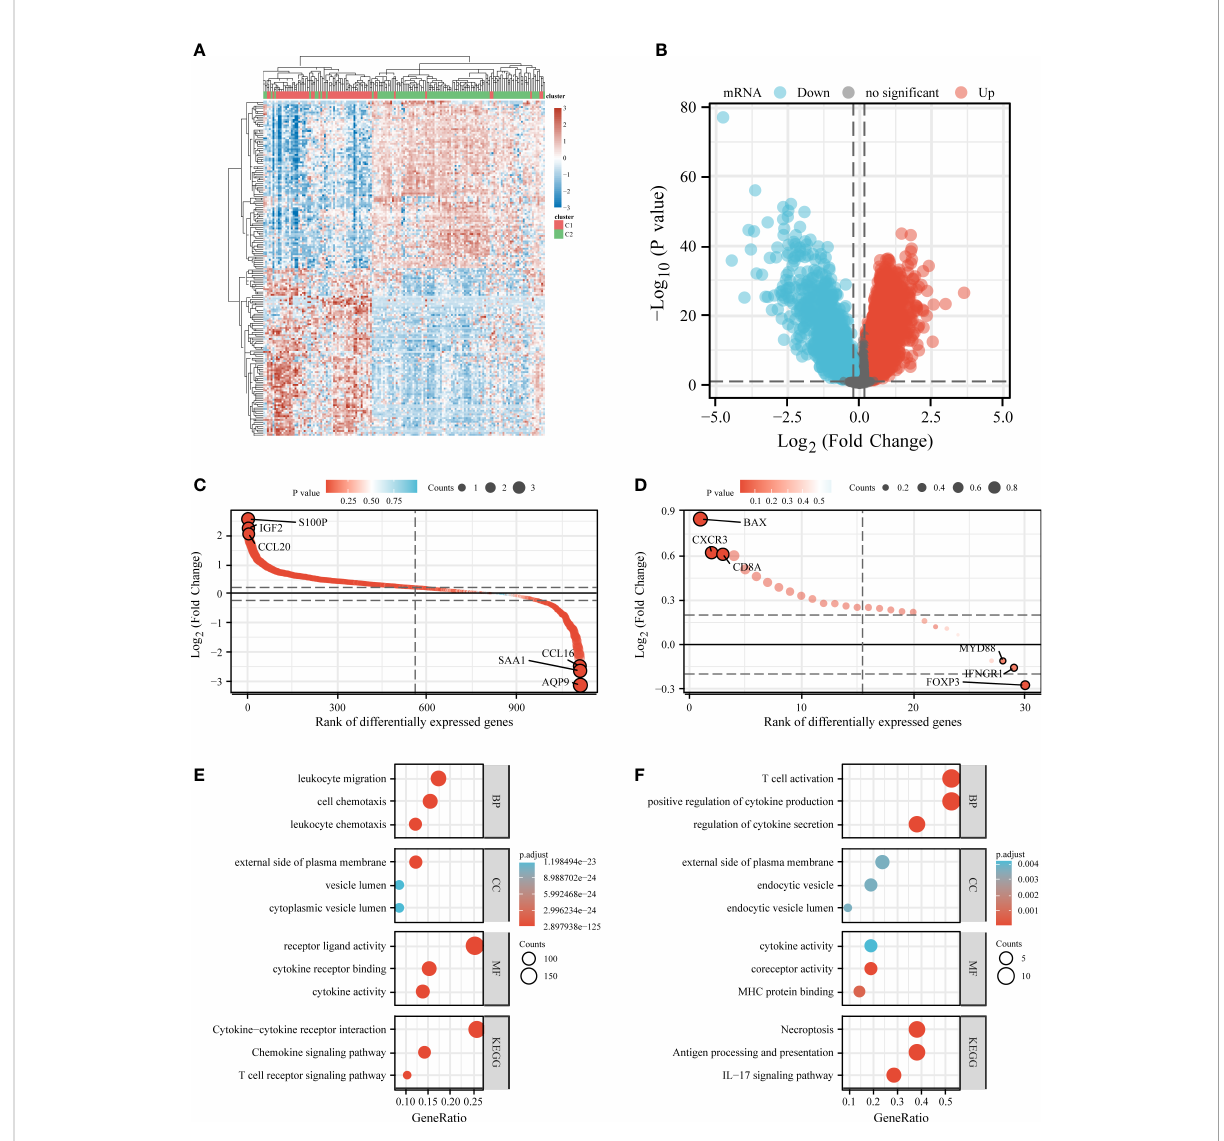
FIGURE 5 Differential expression and enrichment analysis of C1 and C2. Heat map (A) and volcano plot (B) showing differential gene expression between C1 and C2. Rank order plot showing differential expression of IRGs (C) and ICDRGs (D) in C1 and C2. KEGG and GO analysis of differentially expressed IRGs (E) and ICDRGs (F) . IRGs, immune-related genes; ICDRGs, immunogenic cell death-related